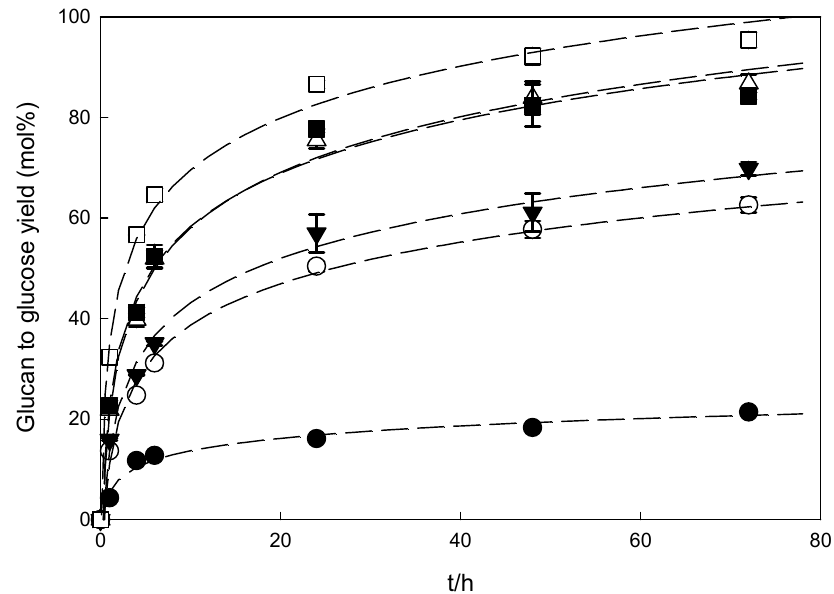
Figure 4. Glucan to glucose yields of wheat straw pre-treated solids that were produced by imidazole pre-treatment. The enzymatic hydrolyses were performed at 2% (w/v) total solids with 60 FPU/g glucan of Cellic CTec2. The dashed lines are only used as a guide for the eye and have no physical meaning.